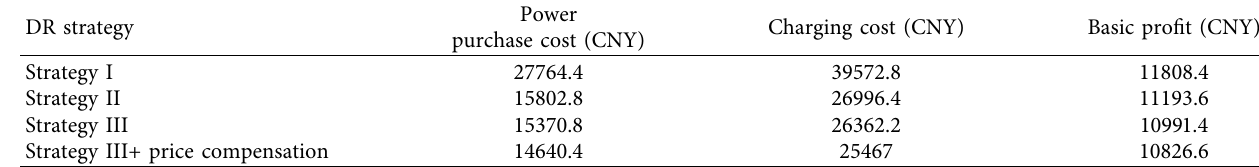
Table 7: Charging cost and power purchase cost under diferent DR strategies.